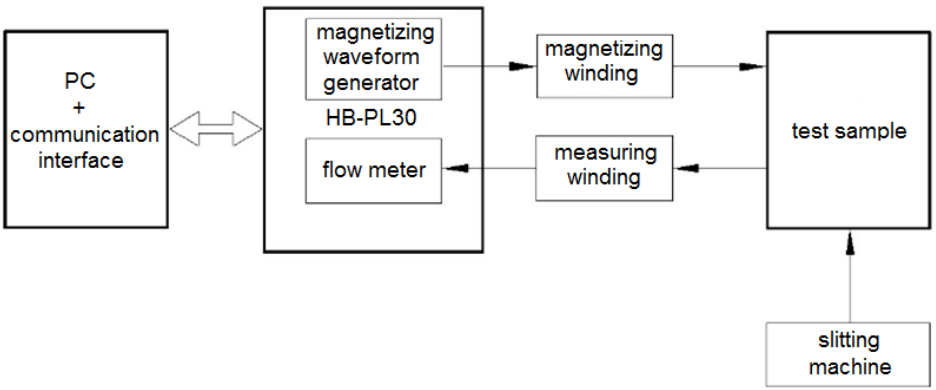
Figure 14. Block diagram of the test stand for testing magnetic characteristics .